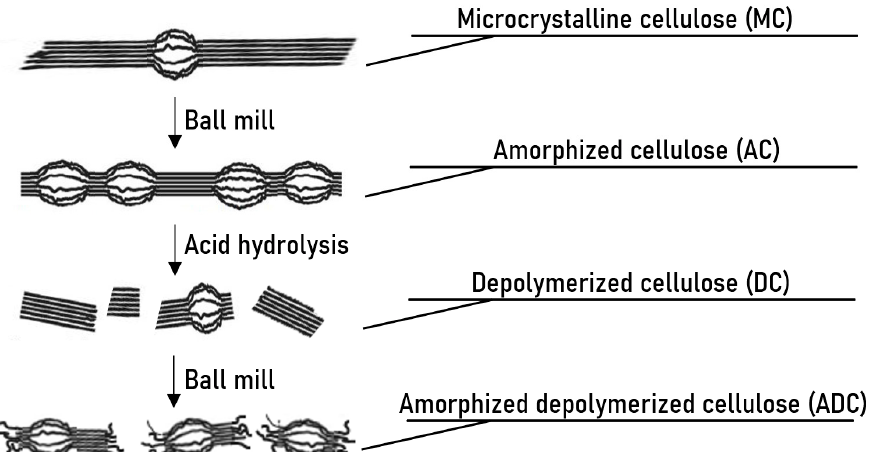
Figure 1. Visual representation of the structural changes during the production process of the different fibers, starting from microcrystalline cellulose (MC), through amorphized cellulose (AC) and depolymerized cellulose (DC), to give amorphized depolymerized cellulose (ADC). Closely packed polymers represent crystalline zones, while paracrystalline zones are visualized by loosely bound polymers.